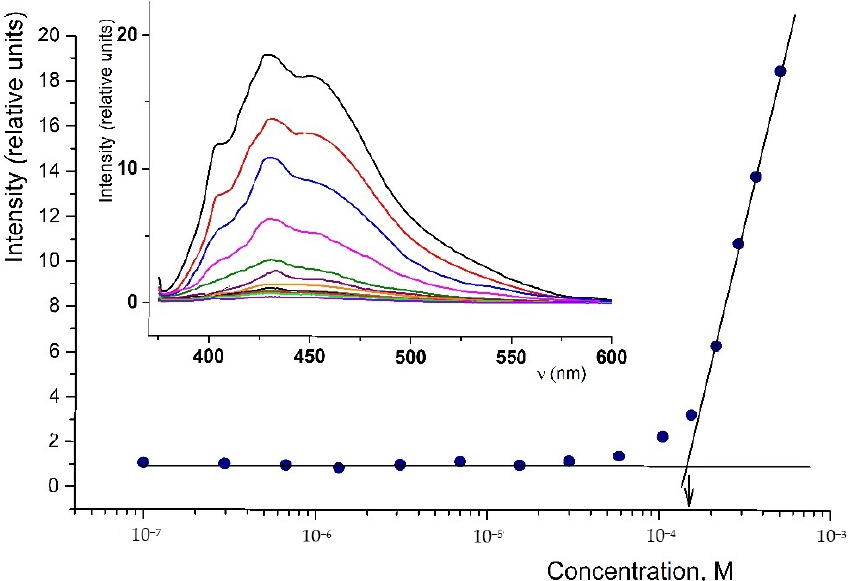
Figure 9. Determination of critical micelle concentration (CMC) values for polymer 3a . Colored lines are fluorescence intensity data obtained for polymer solutions of various concentrations; on their basis, a diagram of intensity vs. concentration was drawn up. The arrow shows CMC.